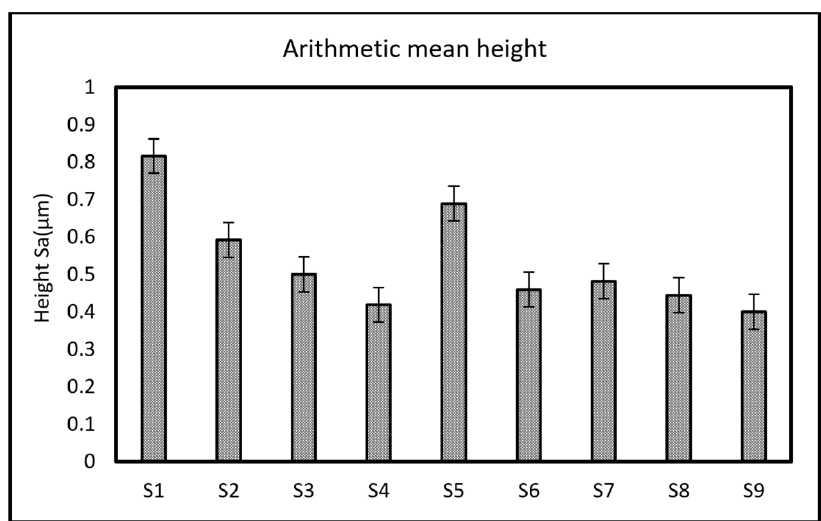
Figure 8. Arithmetic mean height of wear scar on the disk.